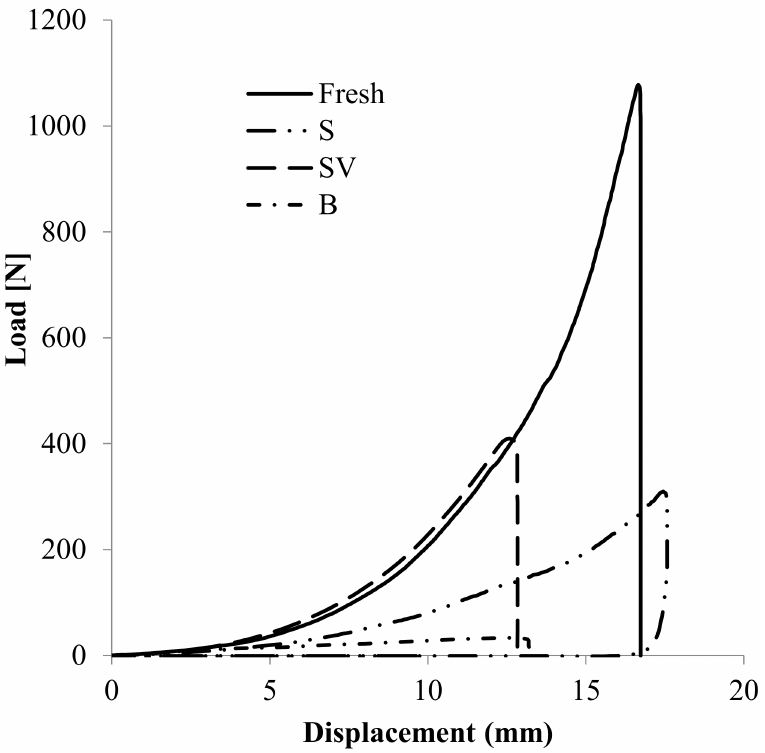
Figure 1. Load-bearing ability in the range of large-scale deformation of untreated (Fresh) and 25-min heated cauliflower ( Cheddar ) under steaming (S), sous-vide (SV), and boiling (B). Texture softening induced by heat on a macroscopic scale was also evaluated using stiffness and strain energy release as two structure-related descriptors. stiffness (N/mm) measures the resistance to the deformation and was calculated as ratio between the load (N) corresponding to 0.5-level deformation (reached at the maximum displacement) and the maximum displacement (mm); then, it was used as a descriptor of the strain-hardening capacity. Strain energy release (N · mm) was calculated as numerical integration of load, displacement data from preload to 0.5-level deformation, and then it was used as descriptor of the work-to-deformation. Decreases in strain energy release as induced by heat was associated with the cumulative damage caused in cell membrane (loss of turgor), cell wall (cell opening), and middle lamella (cell-to-cell separation). Decreasing in stiffness as induced by heat was associated with the damage caused in the cell membrane (loss of turgor) and middle lamella, mainly due to the pectin degradation, causing cell separation. As reviewed by Jarvis et al. [29], thermally induced β -elimination reaction, which occurs during the cooking of vegetables, is a relatively specific method of depolymerizing pectic galacturonans esterified on the galacturonoyl carboxyl group with no known effect on other covalent bonds within the plant cell wall. During cooking, it is commonly accompanied by chelation of divalent cations by organic acids released from within the cell, but it is not normally sufficient to induce cell separation after the cells are dead and the mechanical stress induced by turgor pressure is partly or completely loss as induced by heat. Figure 2 shows the strain energy release and stiffness levels corresponding to the fresh and 25 min heated Cheddar samples under B, S, and SV